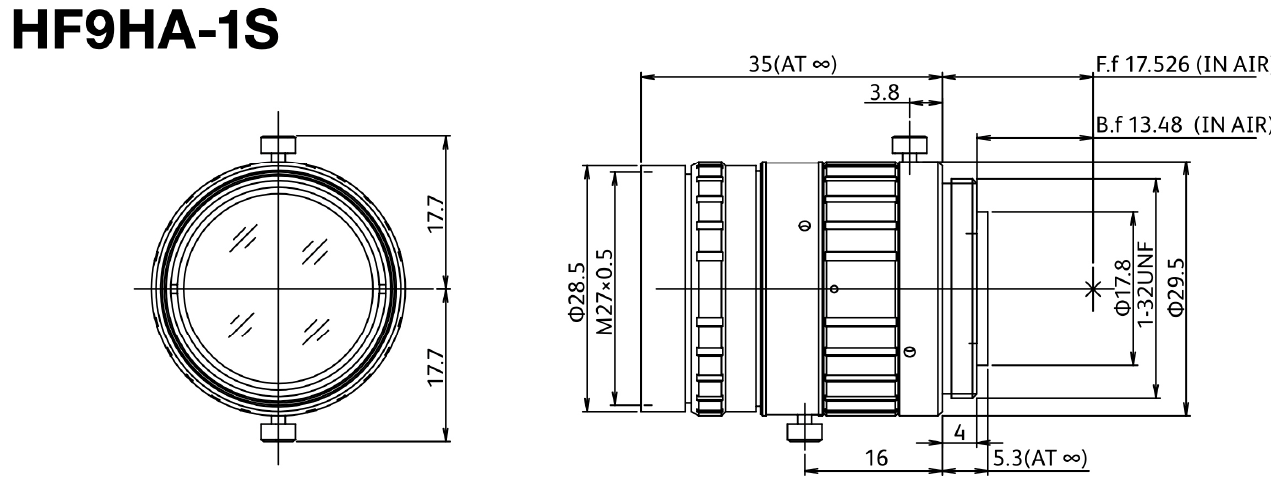
Figure 1. Fujinon lens dimensions.